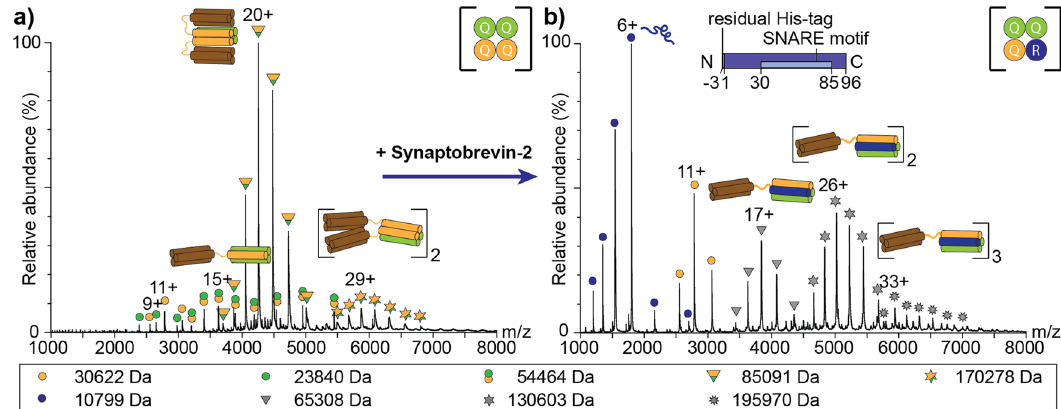
Fig. 2 Formation and reorganization of SNAP25:Syntaxin-1A binary complexes. a SNAP25 and Syntaxin-1A were mixed in a 1:2 ratio and analysed by native MS. Charge state series corresponding to monomeric Syntaxin-1A (orange circle) and SNAP25 (green circle) as well as binary complexes composed of SNAP25 and Syntaxin-1A in a 1:1 (green-orange twin-circles), 1:2 (orange-green triangles) and 2:4 (orange-green stars) stoichiometry were observed. b Addition of Synaptobrevin-2 at a 1.2 molar excess to pre-assembled binary SNAP25:Syntaxin-1A complexes results in formation of the SNAP25:Syntaxin-1A: Synaptobrevin-2 (3Q:1R) SNARE complex. Monomeric Synaptobrevin-2 (blue circles) and Syntaxin-1A (orange circles) as well as monomeric (grey triangles), dimeric (grey hexagonal stars) and trimeric (grey nonagonal stars) SNARE complexes are assigned. The observed molecular weight is given for all proteins and complexes (see